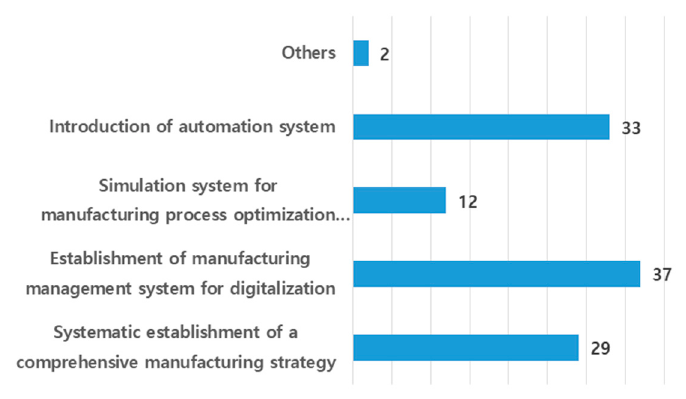
Figure 10. The most important part when promoting smart factory.